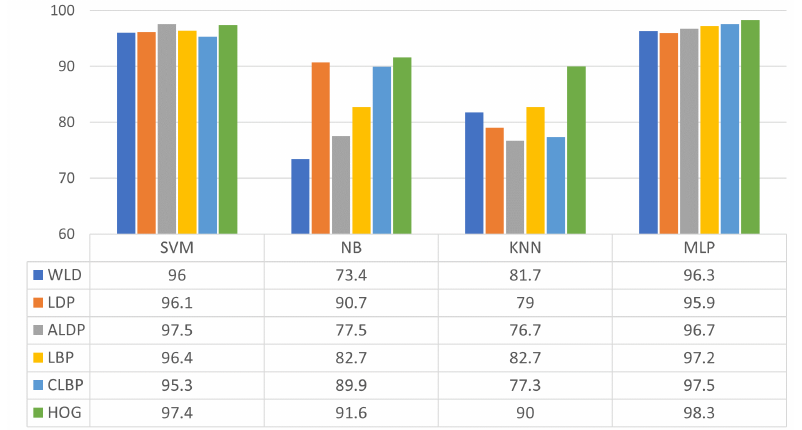
Figure 6. FER results for the best of sub-regions on the CK+ dataset (6 expressions).